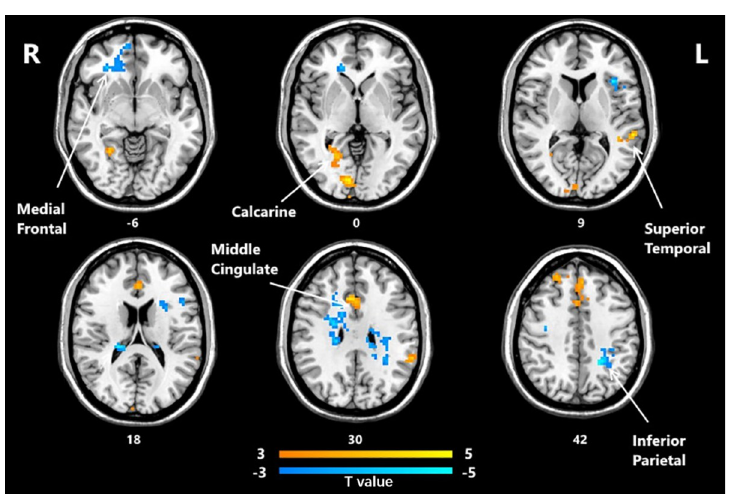
Fig 1. Brain regions that showed significant alterations in fALFF between the group post- HD-tDCS and post- sham group (P < 0.05, AlphaSim corrected). The yellow color denotes HD-tDCS > sham-HD-tDCS in the fALFF values and the blue color denotes HD-tDCS < sham-HD-tDCS. The T-value bars are shown at the bottom. The brain regions with significant increases in fALFF values include Calcarine R, Temporal Sup L, Cingulum Mid R, Frontal Sup Medial R. However, Frontal Med Orb R, Frontal Inf Tri L, Precentral R, Parietal Inf L, and Frontal Inf Oper R decreased significantly. fALFF, fractional amplitude of low-frequency fluctuation; HD-tDCS, high-definition transcranial direct current stimulation.